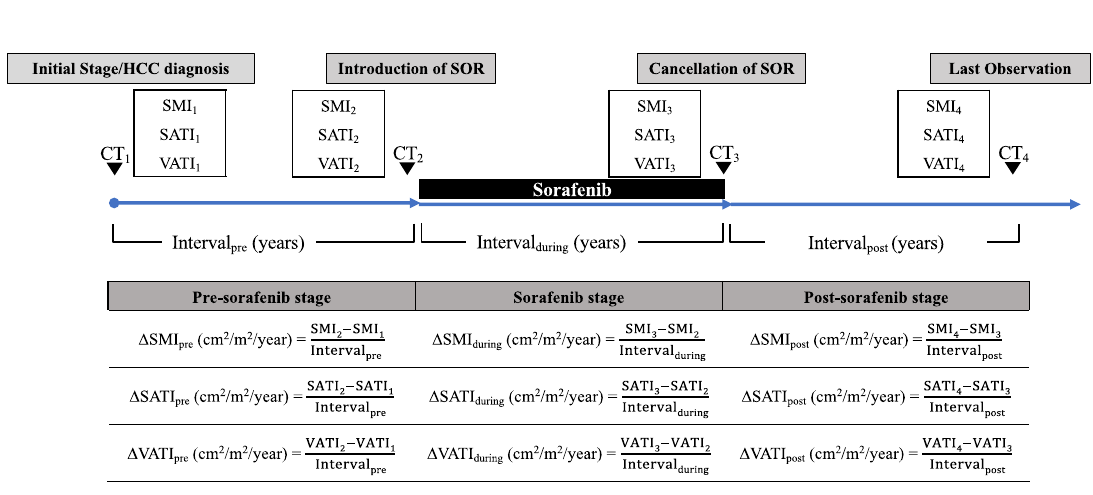
Figure 4. Outline and formula for Δ SMI pre , Δ SATI pre , Δ VATI pre , Δ SMI during , Δ SATI during , Δ VATI during , Δ SMI post , Δ SATI post , and Δ VATI post (cm 2 /m 2 /year). Skeletal muscle index (SMI) was defined as the cross-sectional area of the muscle (cm 2 ) at the L3 level of the computed tomography image, normalized by the square of the height (m 2 ). Subcutaneous adipose tissue index (SATI) and visceral adipose tissue index (VATI) were defined as the cross-sectional areas of the subcutaneous and visceral fat (cm 2 ), respectively, at the umbilical point, normalized by the square of the height (m 2 ).